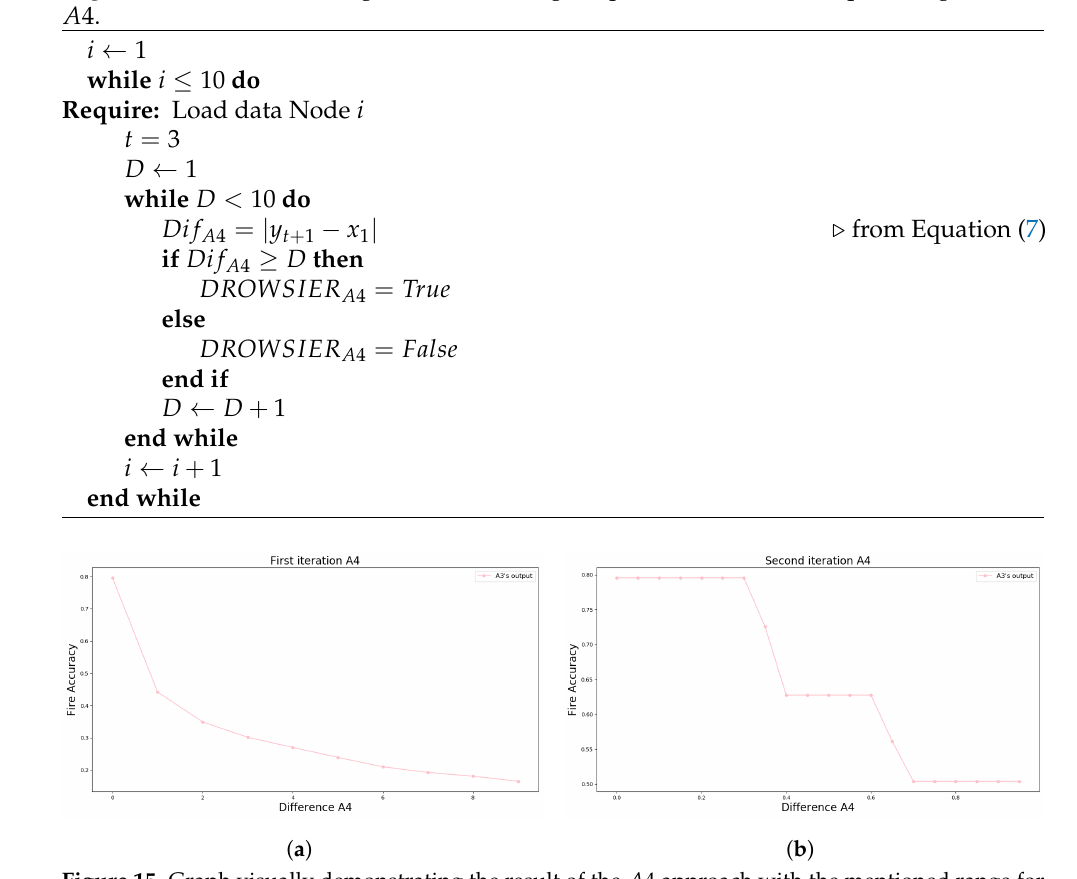
Figure 15. Graph visually demonstrating the result of the A 4 approach with the mentioned range for D using t = 3. ( a ) A 4’s results with D range from 0 to 10 stepping 1. ( b ) A 4’s results with D range from 0 to 0.9 stepping